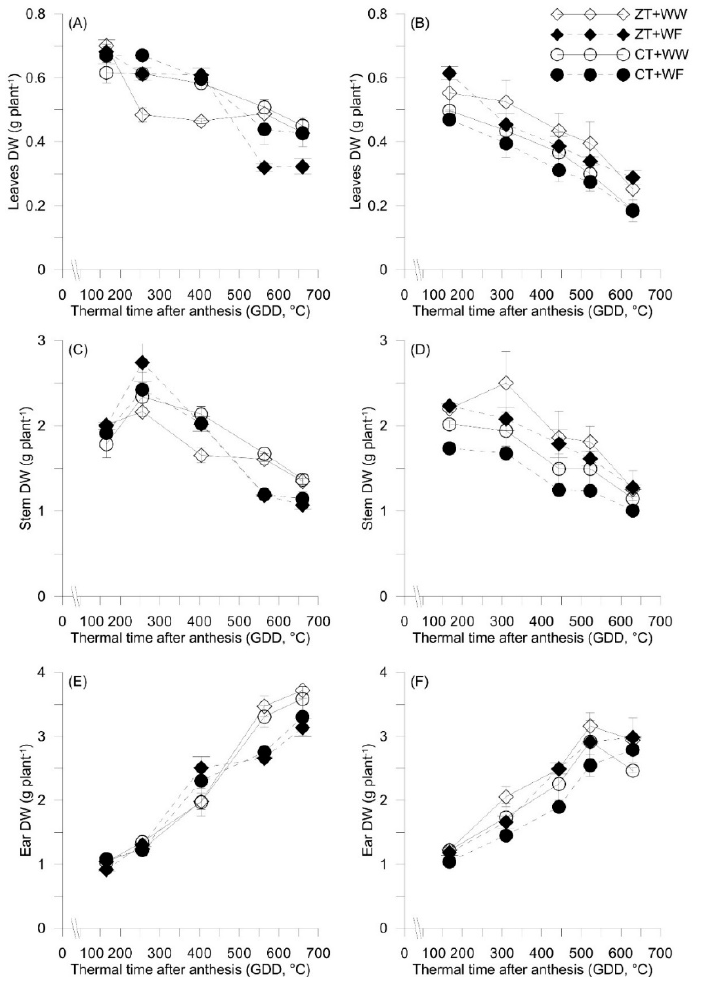
Figure 2. Dynamic of dry weight (DW, g plant − 1 ) of leaves, steam and ear against thermal time after anthesis (°C) of durum wheat in 2016 (A, C and E, respectively) and 2017 (B, D and F, respectively) affected by soil tillage practice and crop sequence ( ○ CT + WW; ● CT + WF; ◊ ZT + WW; ♦ ZT + WF). Treatments: CT, conventional tillage; ZT, zero tillage; WW, durum wheat monocropping; WF, durum wheat-faba bean rotation. Data are averages ± standard errors of n = 3 independent replicates. Table 2. Dry weight (DW) remobilization efficiency (DWRemE, % of vegetative DW) and nitrogen (N) remobilization efficiency (NRemE, % of vegetative N) in the 2016 and 2017 cropping seasons. Means followed by different letters (upper case letters: main effects; lower case letters: effects of interaction) significantly differ according to Tukey’s HSD test ( p < 0.05). Treatments: CT, conventional